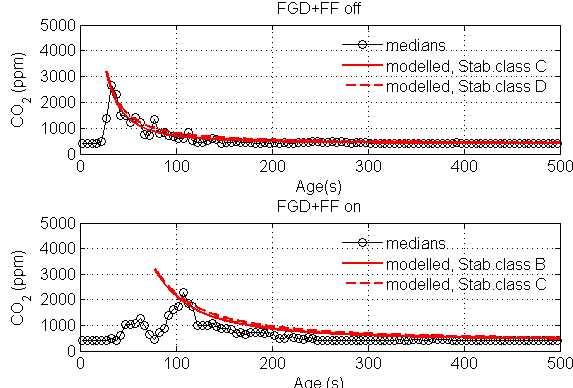
Figure 4. Comparison of measured and modelled CO 2 concentra- tions. Median of measured values are shown with black (circle) symbols along with the standard deviations. Dashed and dotted red lines correspond to model results for stability classes b and c (top panel) and c and d (bottom panel), respectively. The correlation co- efficients between the model and the measurements are shown